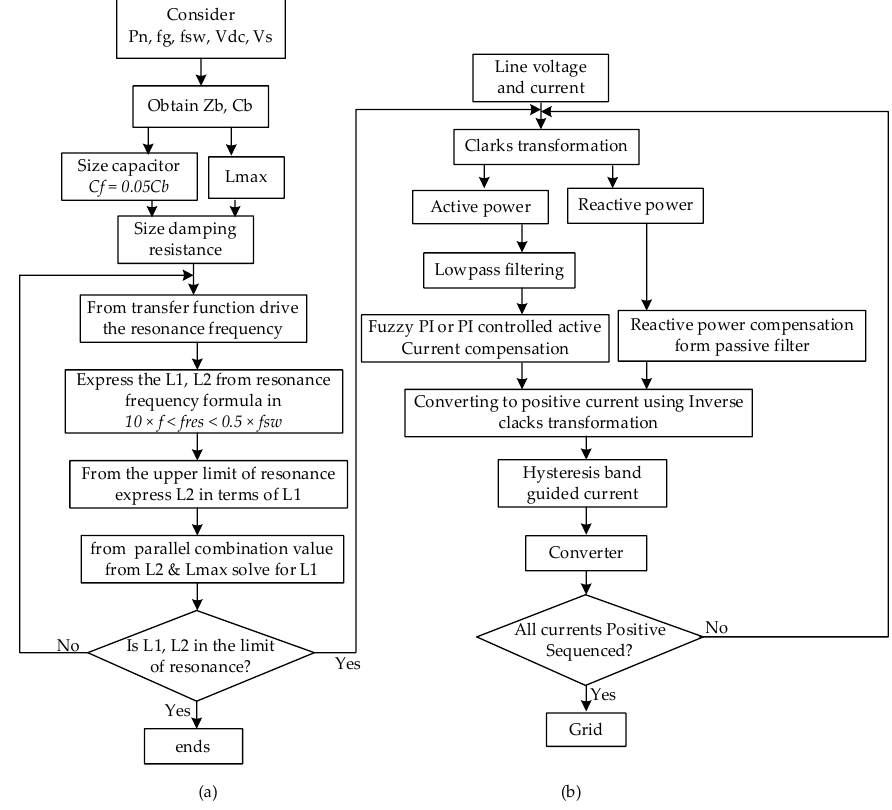
Figure 5. Parameter and working principle of the LCL-HPF ( a ) active and passive filter parameter computation and ( b ) the designed filter working algorithm. computation and ( b ) the designed filter working